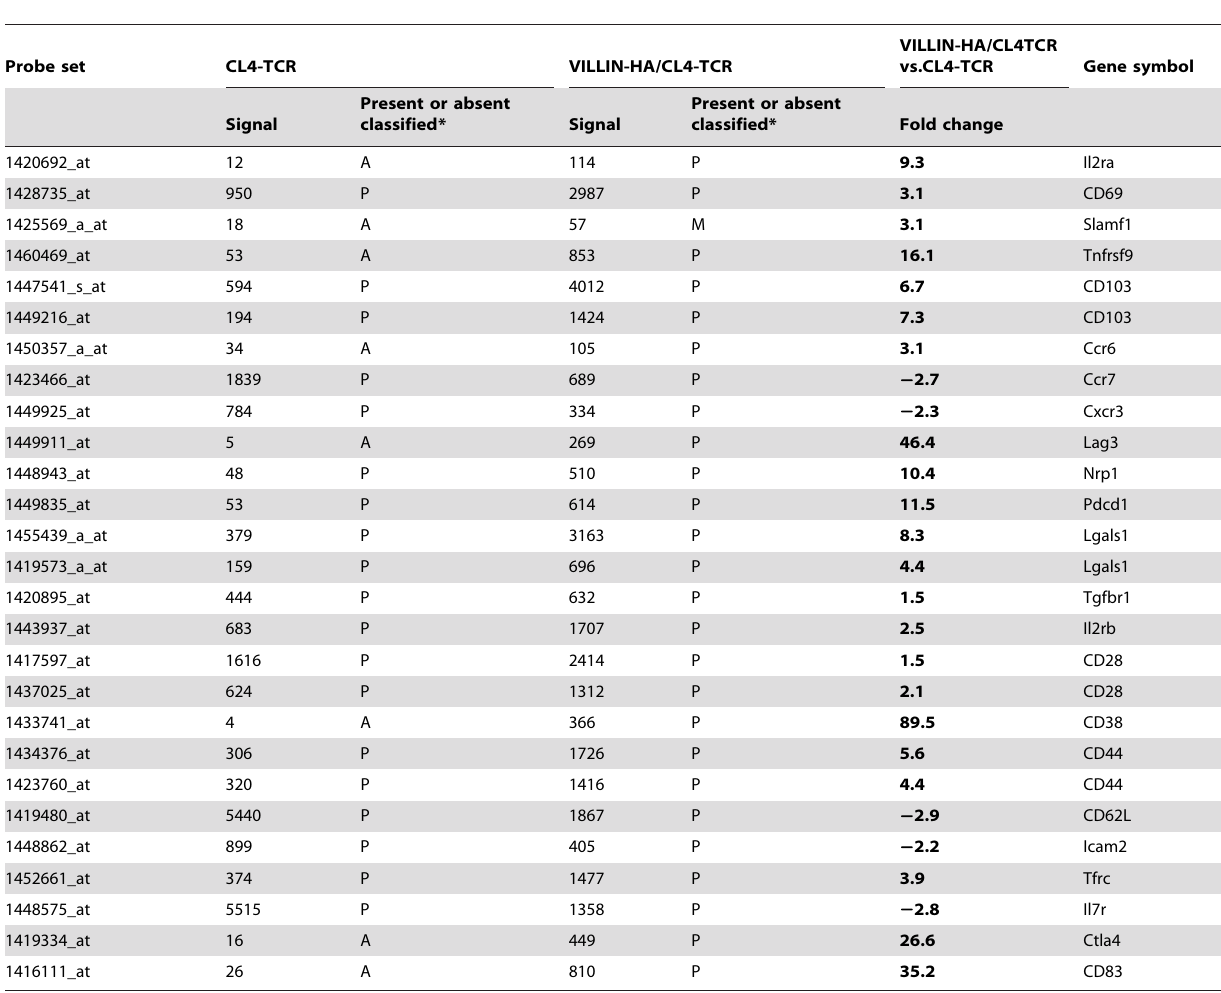
Table 2. Differentially gene expression of T reg -associated genes by HA-specific CD8 + T cells isolated from MLN of CL4-TCR and VILLIN-HA/CL4-TCR transgenic